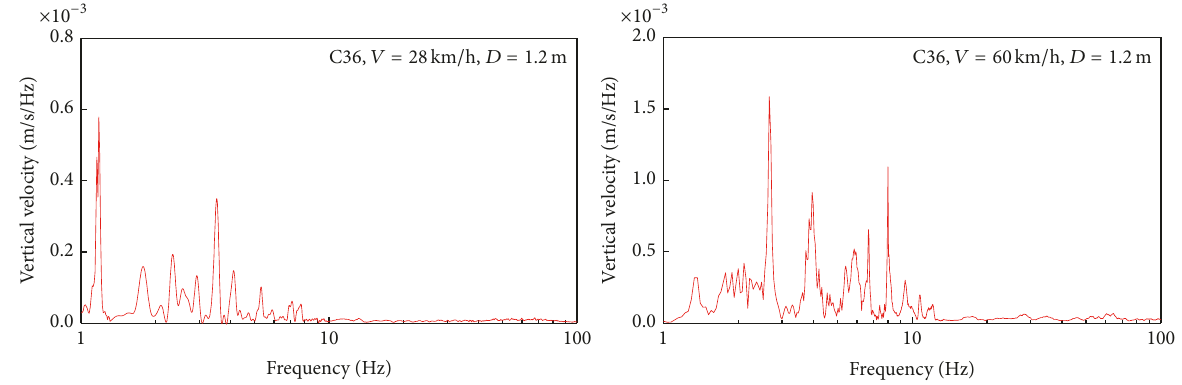
Figure 8: Frequency spectrum of sleeper vibration velocity with train speed of 28 km/h and 60 km/h.